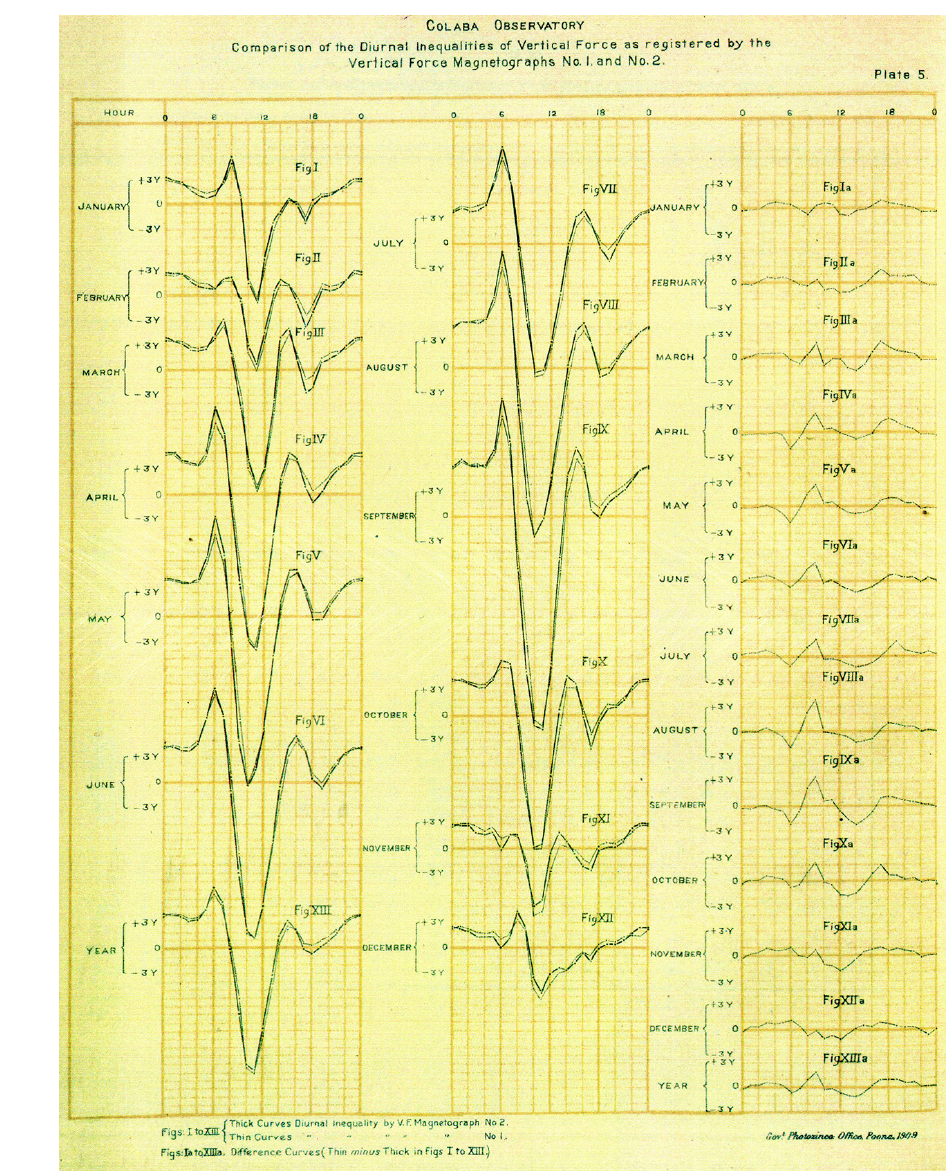
Figure 14. Photograph showing a comparison of diurnal inequalities of vertical force (Moos,